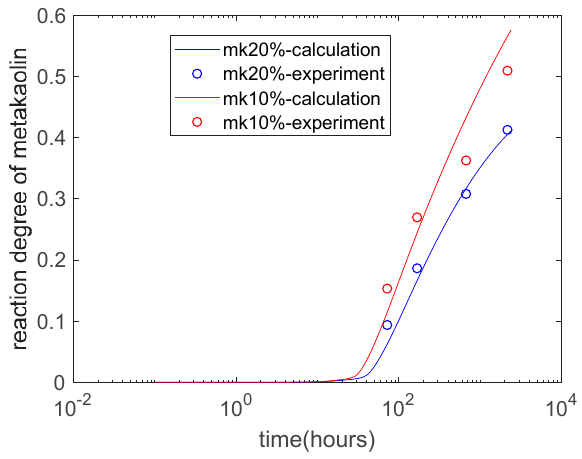
Figure 1. Experimental versus predicted values for the degree of reaction of metakaolin. Seddik et al. [26] performed extensive experimental studies on the strength of metakaolin composite concrete. The mixtures of specimens are shown in the Table 1. In total, 24